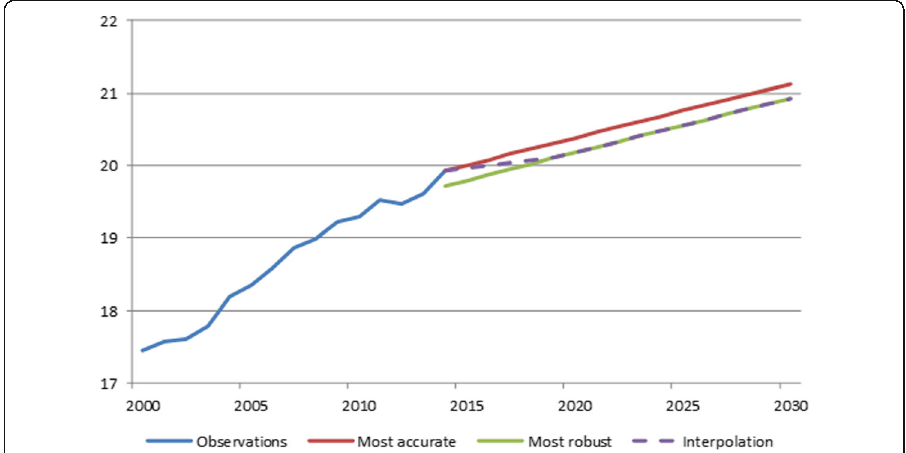
Fig. 3 Example of forecasts with interpolation from the forecast with the option for the jump-off rates which is considered the most accurate to the forecast with the option for the jump-off rates which is considered the most robust, the Netherlands, men and women combined, Lee-Carter model, fitting period 1960 –